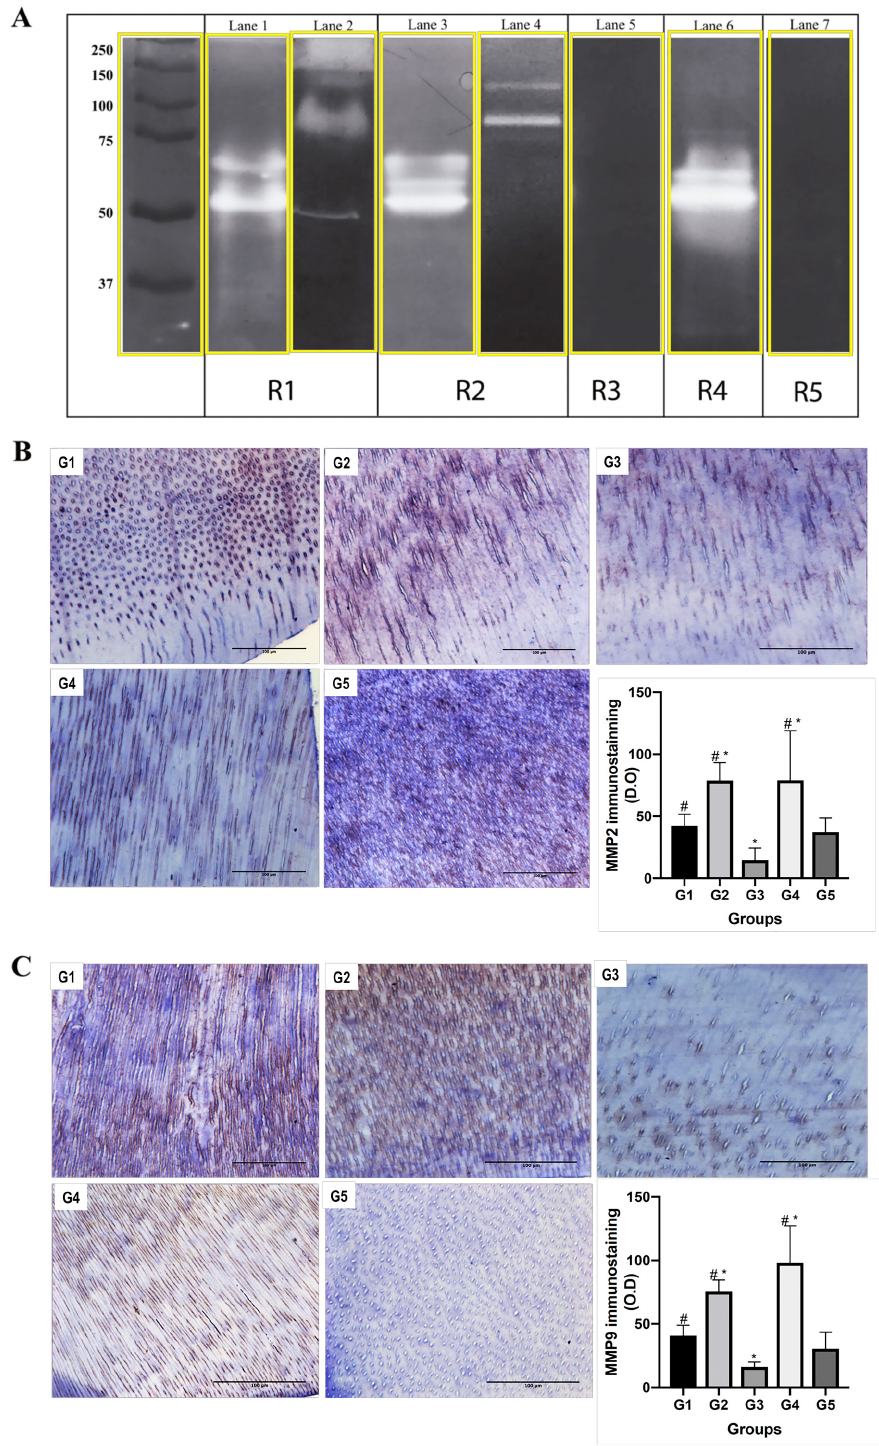
Figure 4. Presence of matrix metalloproteinases. ( A ) Representative lanes of di ff erent zymography gels, showing the presence of gelatinolytic bands at 54 (MMP-20), 68 (MMP-2), and 92 kDa (MMP-9). Uncropped zymograms in Supplementary Material—Figure S3. ( B ) Representative images of MMP-2 immunohistochemical analysis (40 × ). Scale bars, 100 µ m. ( C ) Representative images of MMP-9 immunohistochemical analysis (40 × ). Scale bars, 100 µ m. Immunostaining was observed mainly in the intratubular dentin. Samples were treated with chlorhexidine to inhibit the activity of MMPs and used as a negative control (G5). At the right bottom of b and c, immunostaining is expressed as optical density (OD). Each bar represents the mean ± standard error of the mean. * p < 0.05 versus G1 (control group). # p < 0.05 versus